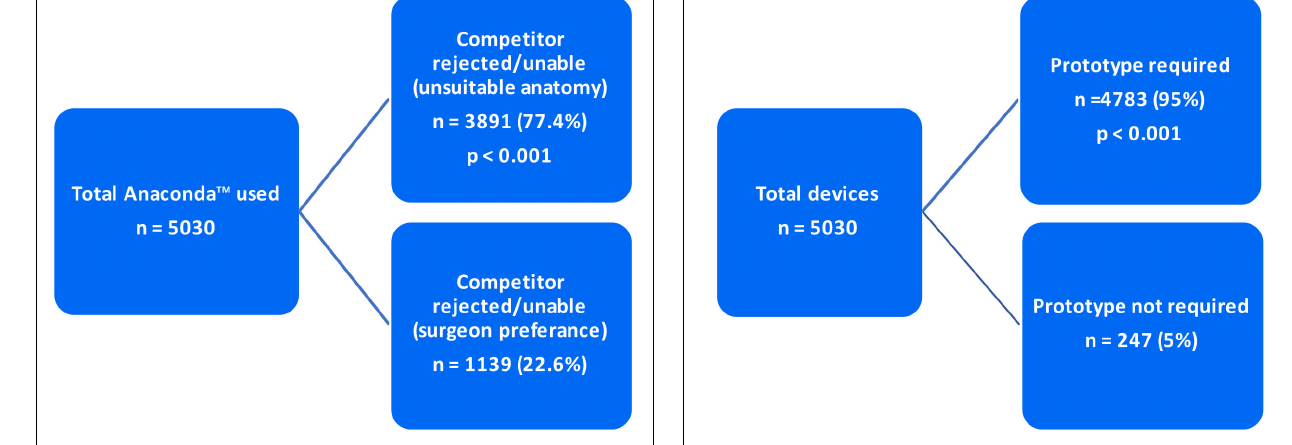
FIGURE 6 | AnacondaTM prototype